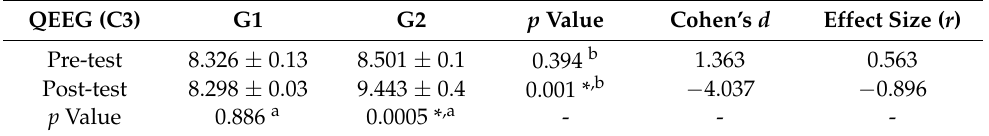
Table 4. Peak frequency of alpha wave of motor area (C3) of ipsilesional hemisphere in both groups. QEEG